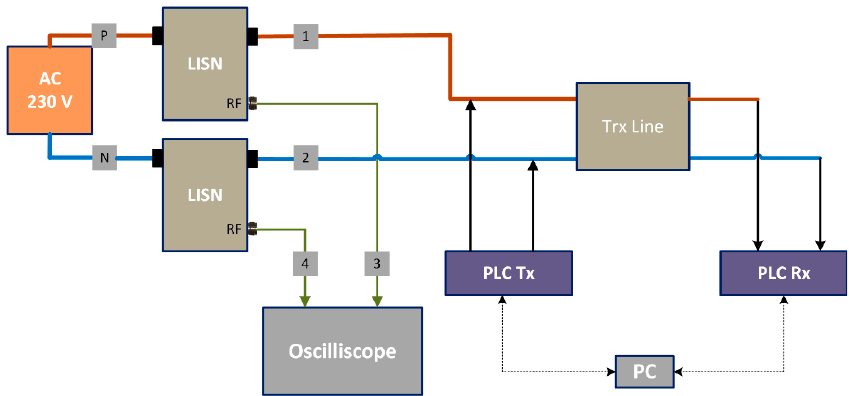
Figure 2. Principal diagram of the setup for PLC modeling.